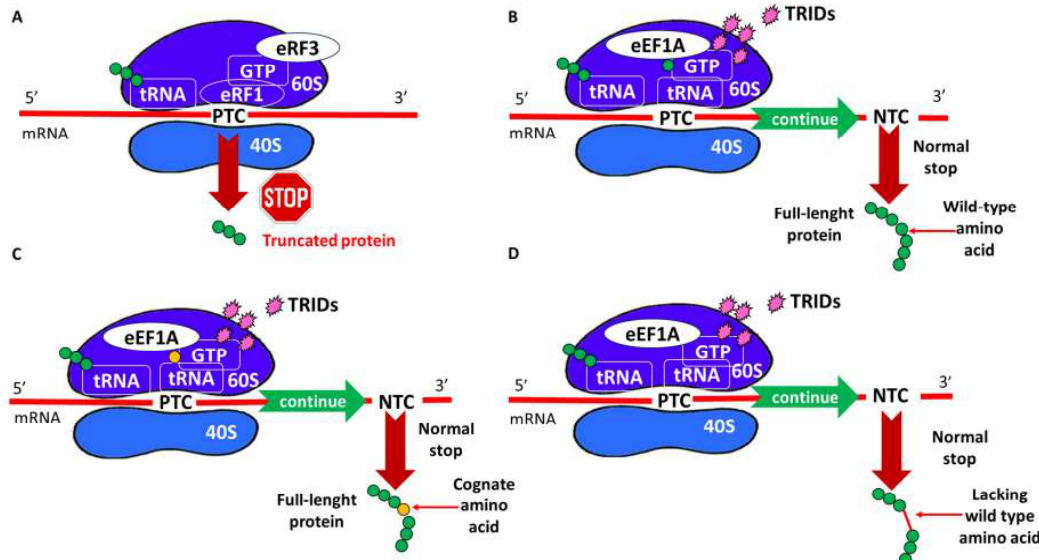
Figure 2. ( A ) Translation of premature termination codon (PTC)-containing mRNA in the absence of translational readthrough-inducing drugs (TRIDs); ( B ) ideal readthrough of PTC; ( C ) readthrough inserting a cognate amino acid; and ( D ) readthrough skipping amino acid insertion. Figure legend: mRNA, RNA messenger; tRNA, RNA transfer; 40S and 60S, small and large ribosome subunit, respectively; eEF1A, eukaryotic translation elongation factor 1A; eRF1 and eRF3, eukaryotic translation termination factor 1 and 3, respectively; and GTP, guanosine-5’-triphosphate.